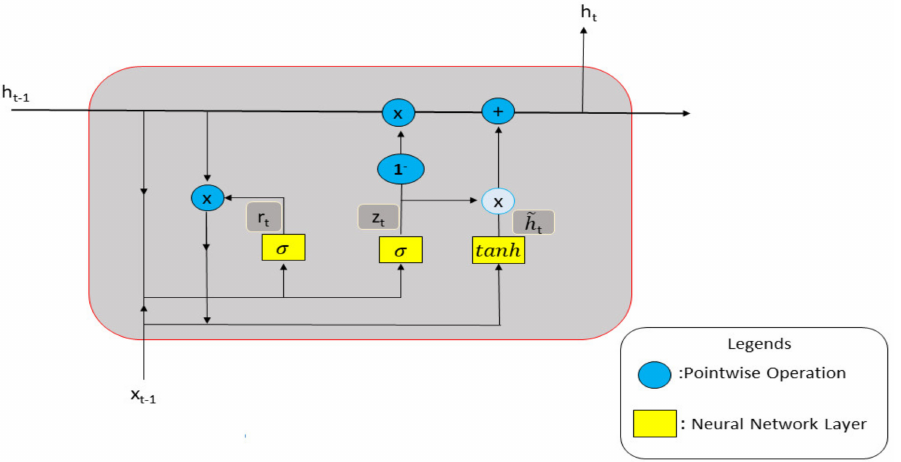
Figure 2. Representation of a GRU